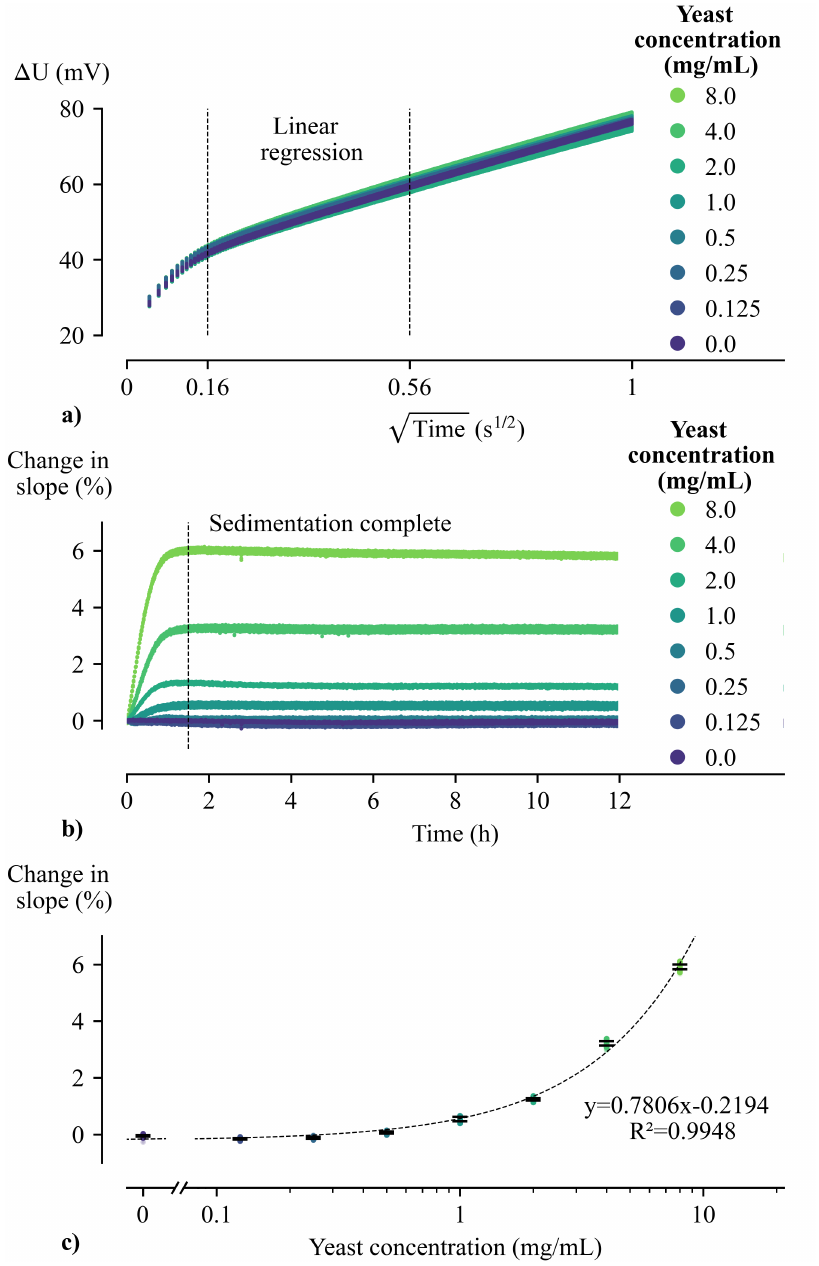
Figure 4. ( a ) Constant current pulses were applied to different sensors whilst various cell suspensions were left to sediment on the sensor surface. The resulting voltage changes measured over the metal structures are plotted on top of each other. It is expected that an increasing amount of cells at the sensor interface will result in a steeper slope within the selected linear regression interval. ( b ) The percentage change in slope is plotted as a function of time. For each concentration, this plot contains data of four unique sensors. It is clear that the slope of the sensor temperature response is influenced by the amount of cells at the interface. Within the first 1.5 h, cells accumulate at the sensor surface over time, and thereby cause an increase in slope. After the sedimentation is complete, the sensor signal remains stable over time for all sensors. ( c ) The sensor response after sedimentation, from 2 h to 12 h, is plotted as a function of the concentration of the added cell suspension (logarithmic scale). This plot illustrates the linearity of the sensor response to a varying amount of cells at the interface. Within the demonstrated range, the average standard deviation is 0.29